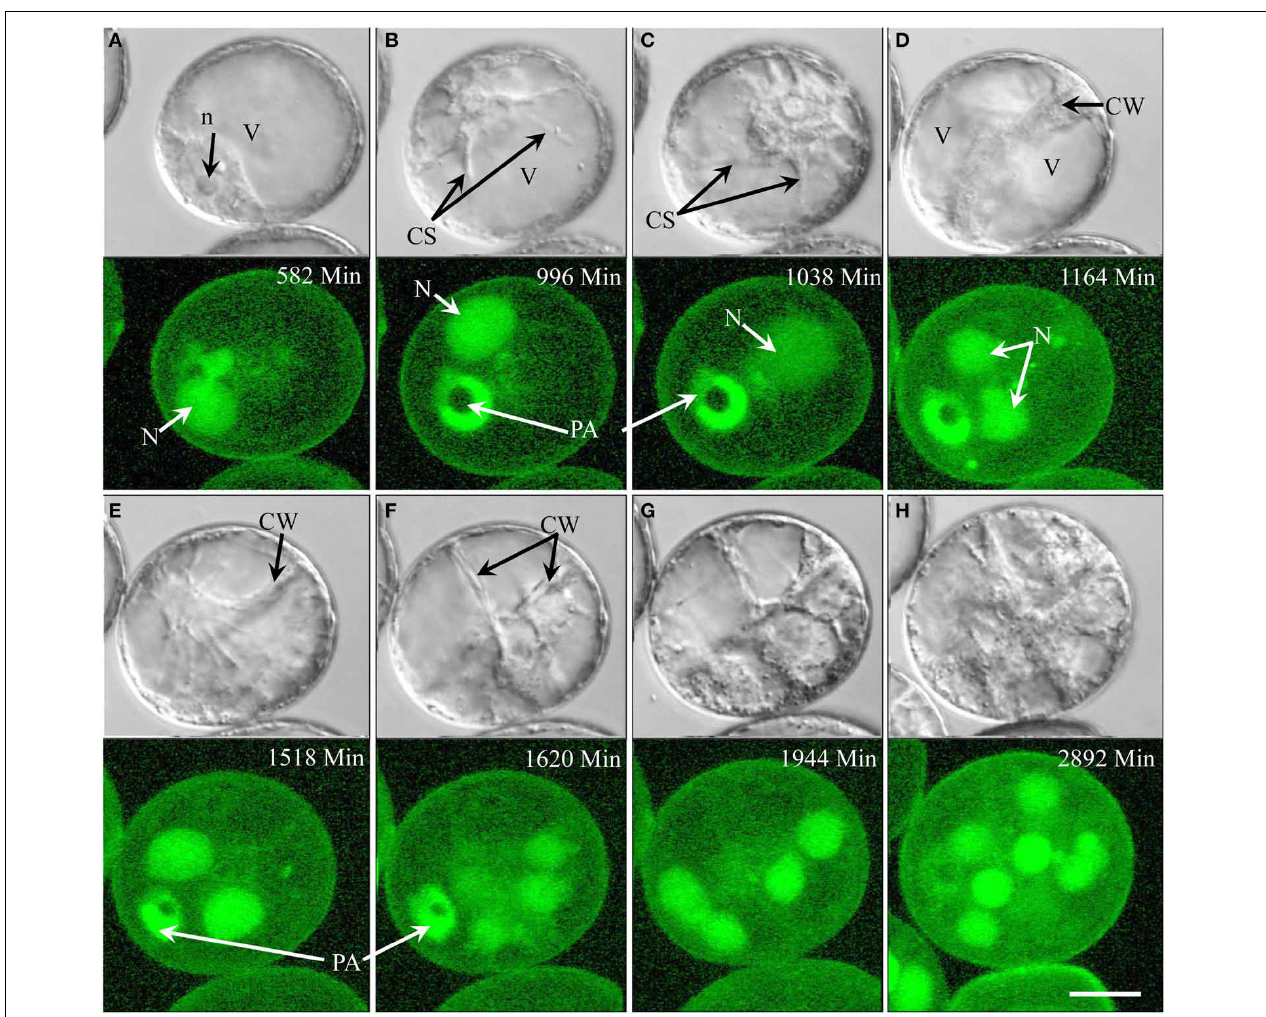
FIGURE 2 | Time-lapse of type I development (embryogenic pollen) shown by synchronously acquired DIC and fluorescence images. (A) Uni-nucleate pollen (microspore) with nucleus close to pollen aperture. (B,C) The nucleus has migrated away from the pollen periphery and cytoplasmic strands are formed. The blurred fluorescence signal indicates the break-down of the nuclear envelope prior to mitosis. (D) Newly formed cell wall (DIC) and